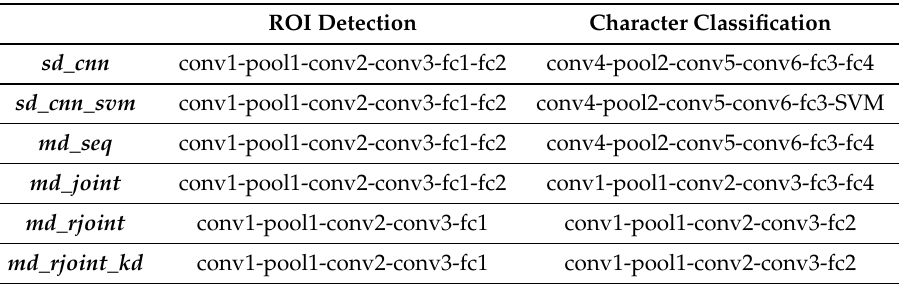
Table 1. The network structure for each method.